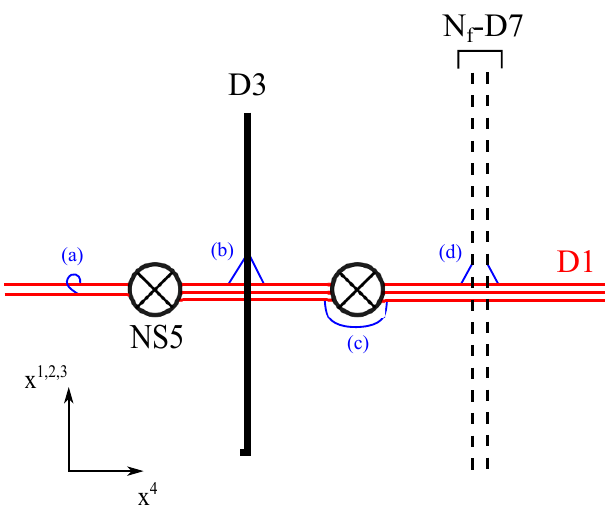
Figure 3 . This (cid:12)gure illustrates which strings give rise to the various (cid:12)elds in the bubbling SQM. (a) describes the D1-D1 strings that give rise to a N = (0 ; 4) vector multiplet with (cid:12)elds ( v t ; (cid:27); (cid:21) A ), (b) describes the D1-D3 strings that give rise to N = (0 ; 4) fundamental hypermultiplets with (cid:12)elds ( (cid:30) A ; I ), (c) illustrates D1-D1’ strings that give rise to N = (0 ; 4) bifundamental hypermultiplets with (cid:12)elds ( (cid:30) A ; ), and (d) describes D1-D7 strings that give rise to the short N = (0 ; 4) Fermi I multiplets with (cid:12)elds ( (cid:17); G